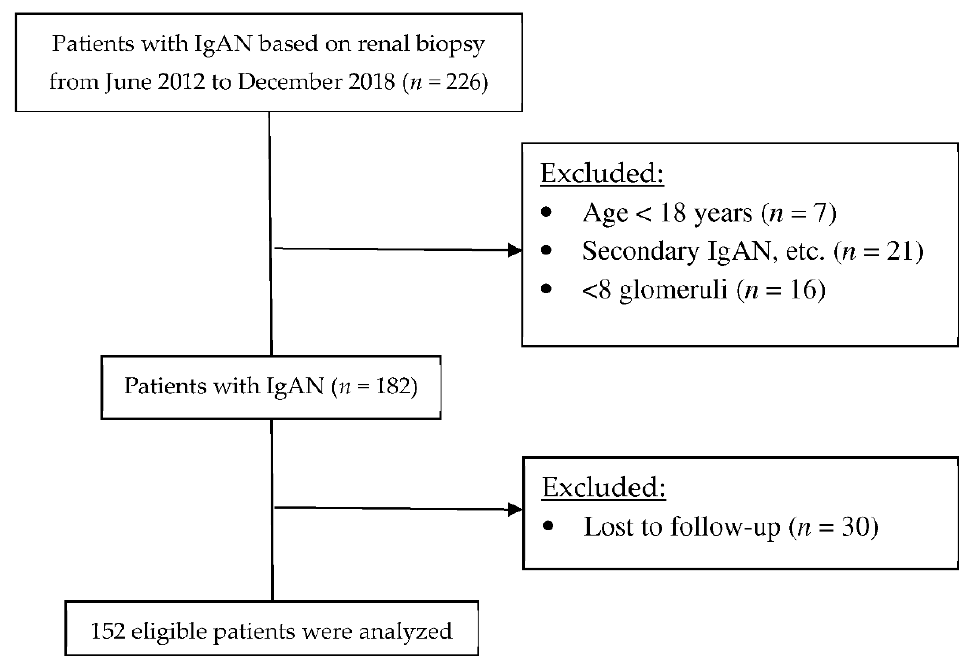
Figure 1. The study flow chart of the enrolment of IgAN patients.